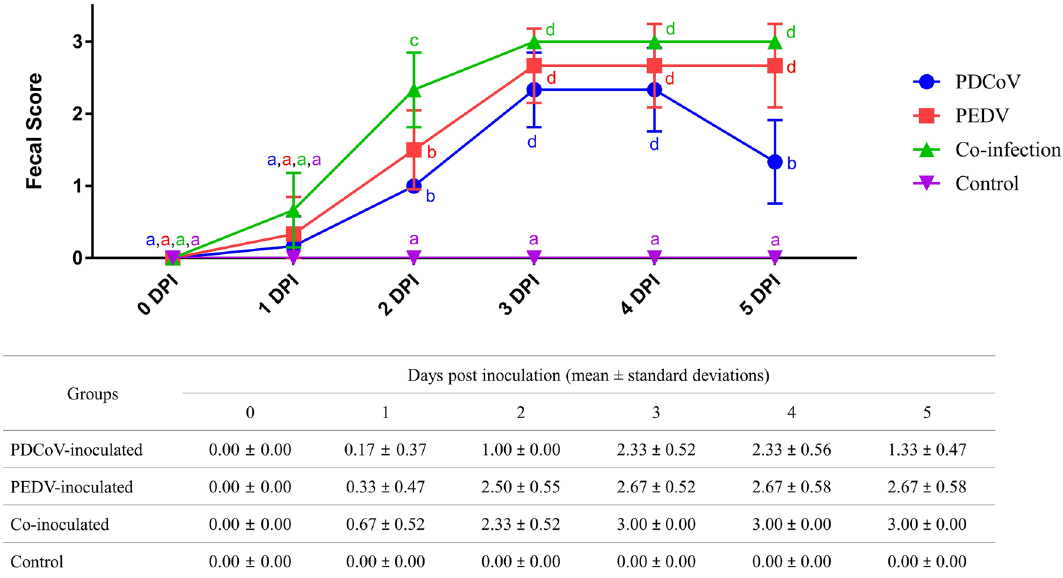
Figure 1. Fecal scores of piglets at 0- to 5-days post-inoculation (dpi). Blue circles, red squares, green triangles, and purple triangles represent PDCoV-inoculated, PEDV-inoculated, co-inoculated, and control groups. Different lower-case letters indicate significant differences between each group and each dpi ( p < 0.05). Values of mean ± standard deviation (SD) of each group, and each dpi are presented in a table under the